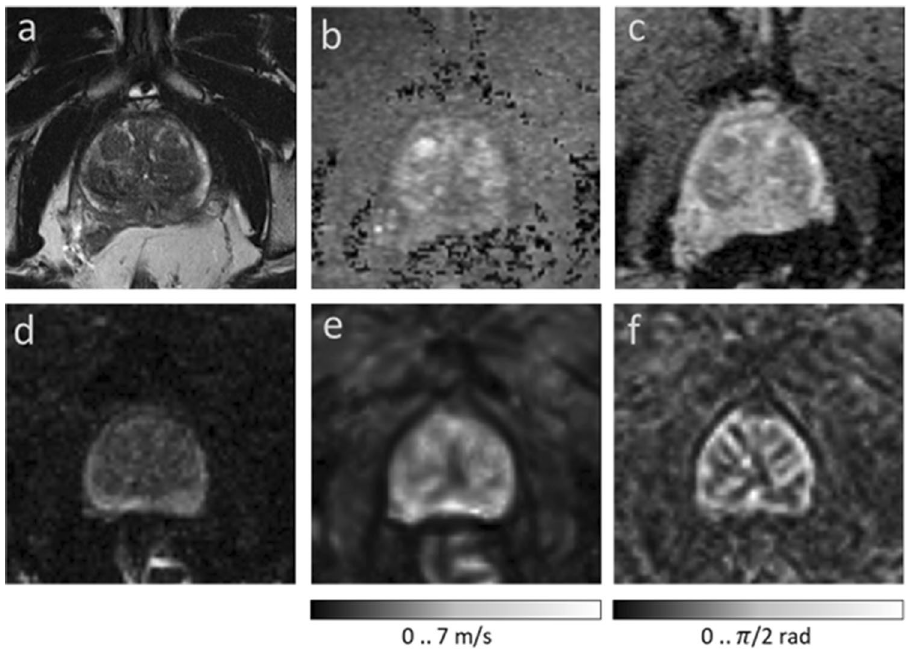
Figure 1. Images illustrating the appearance of the prostate in mpMRI in a volunteer with benign prostate hyperplasia (BPH). ( a ) T2-weighted MRI, ( b ) DWI image with a b-value of 1400 s/mm2, ( c ) ADC map, ( d ) MRE magnitude signal, ( e ) SWS map as a surrogate marker of tissue stiffness, and ( f ) ϕ map, which signifies friction or tissue